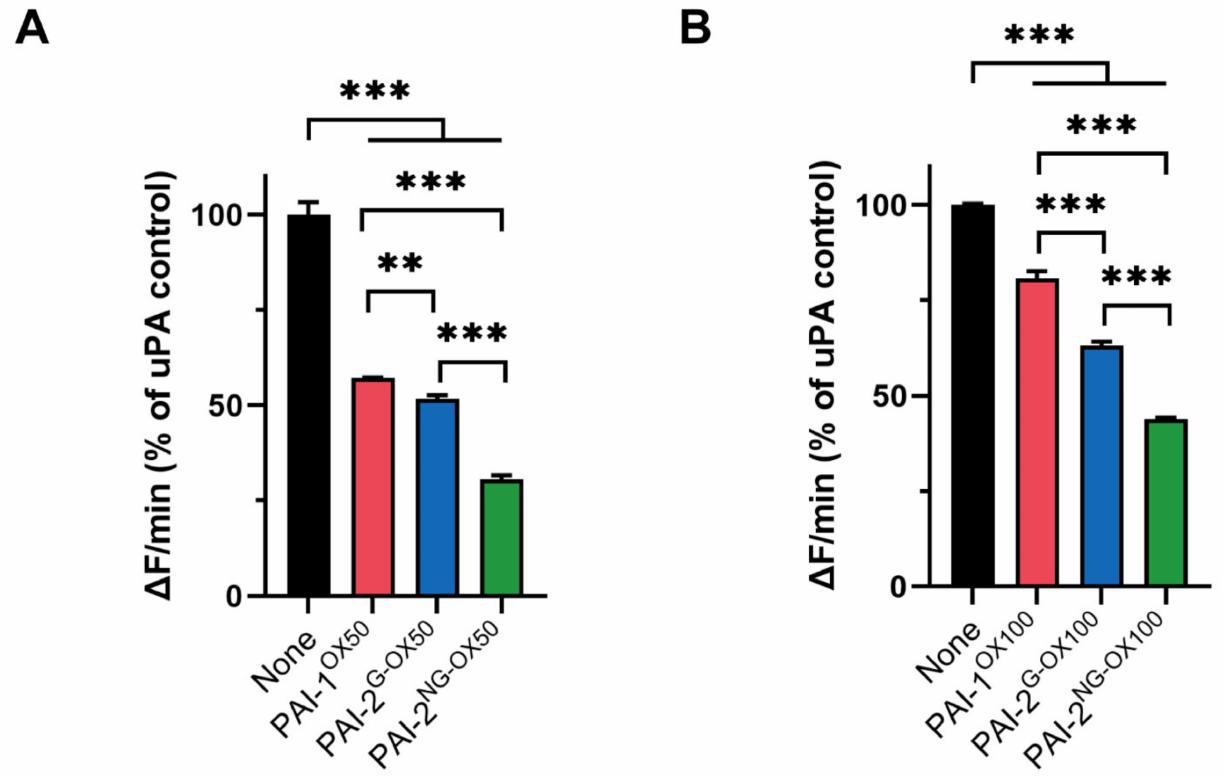
Figure 2. The uPA inhibitory activities of PAI-2 G and PAI-2 NG are more resistant to hypochlorite than PAI-1. PAIs pre-treated with either ( A ) 50 µ M NaOCl (OX50) or ( B ) 100 µ M NaOCl (OX100) were added to the uPA fluorescence substrate containing uPA at a 1:1 molar ratio. None = uPA in buffer alone, no PAIs added. Change in fluorescence/min ( ∆ F/min) for each treatment over 1 h was converted to a percentage of the maximal (uninhibited) uPA activity. Values shown are the means ± SD ( n = 3) from a representative experiment repeated 3 times. One-way ANOVA with post-hoc Tukey’s HSD was used to identify non-significant (ns) and significant differences (*** = p < 0.001; ** = p < 0.01). Kinetic curve data are presented in Figure